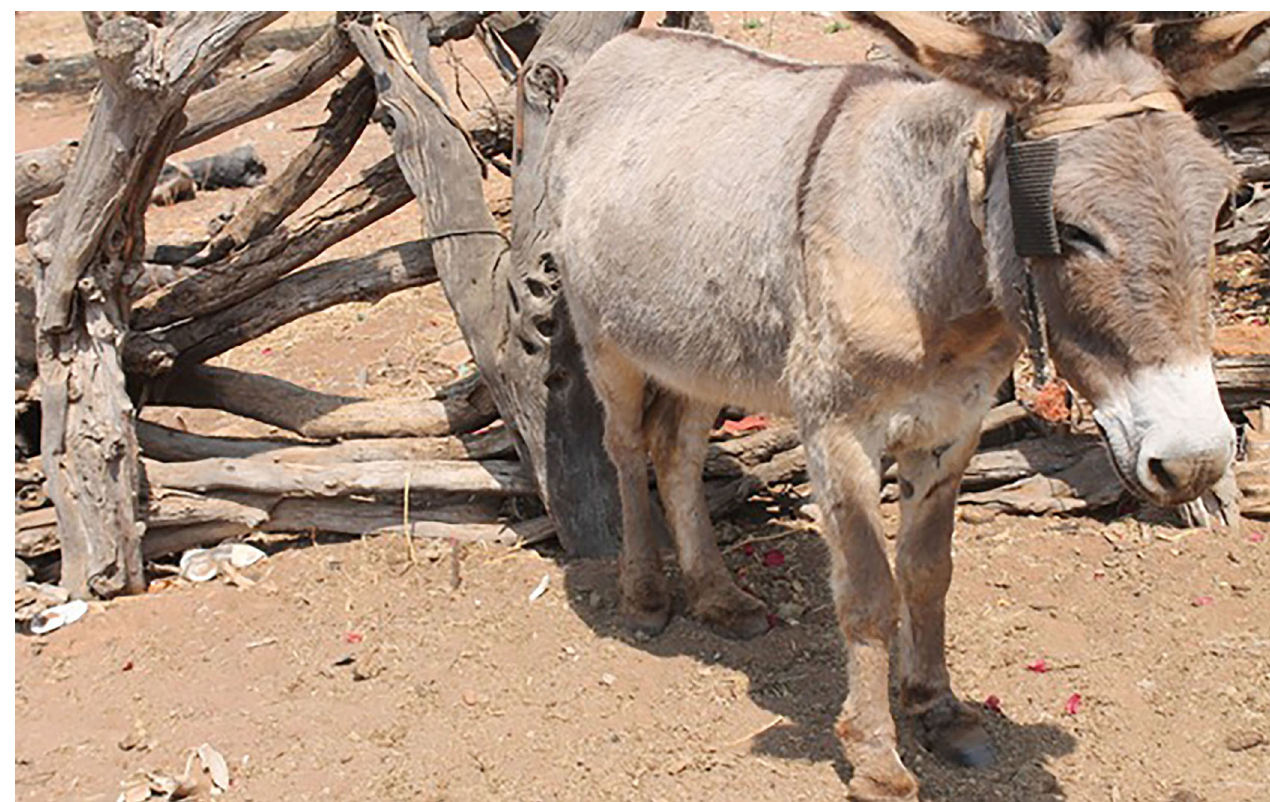
Fig 7. Chuck coal